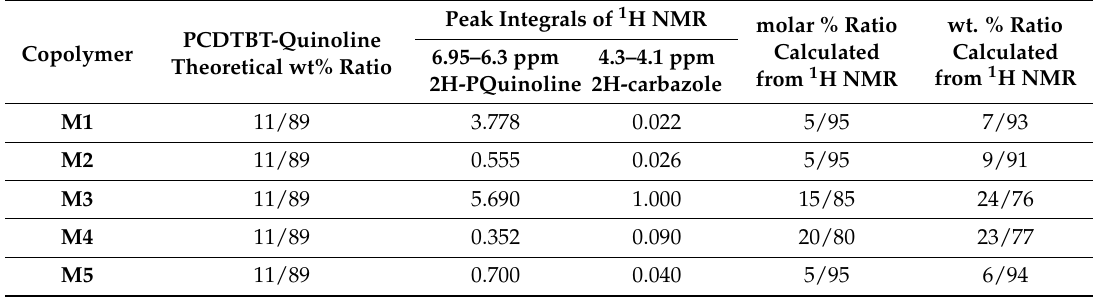
Table 1. Theoretical and Experimental Ratio of PCDTBT:Quinoline for the copolymers M1 – M5 .